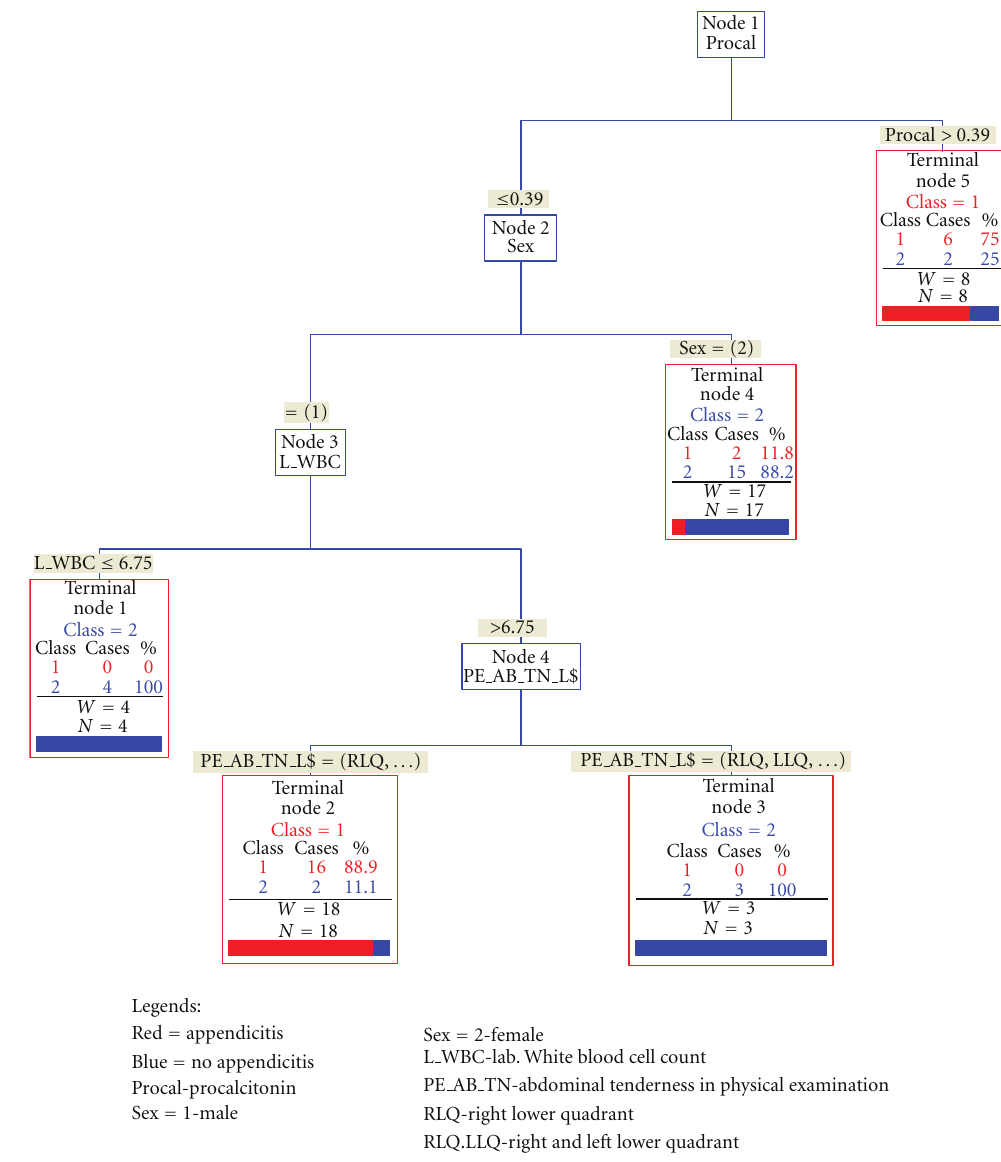
Figure 1: Recursive partitioning model